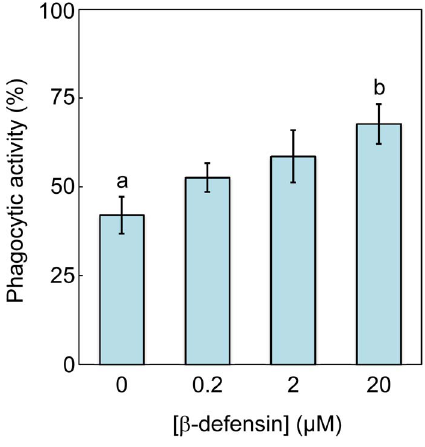
Figure 9. Effect of cod beta-defensin on phagocytic activity of cod head kidney leucocytes. Data are represented as mean 6 SEM (n=5) and different letters indicates significant between two groups (p ,